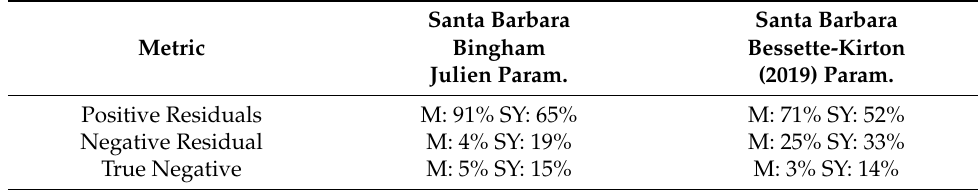
Figure 2. Santa Barbara debris flow models in HEC ‐ RAS with best estimate parameters. The simulated mudplain extents (brown) are mapped with Kean et al.’s (2019) [1] measured mudplains (black). Table 3. Santa Barbara depth metrics.